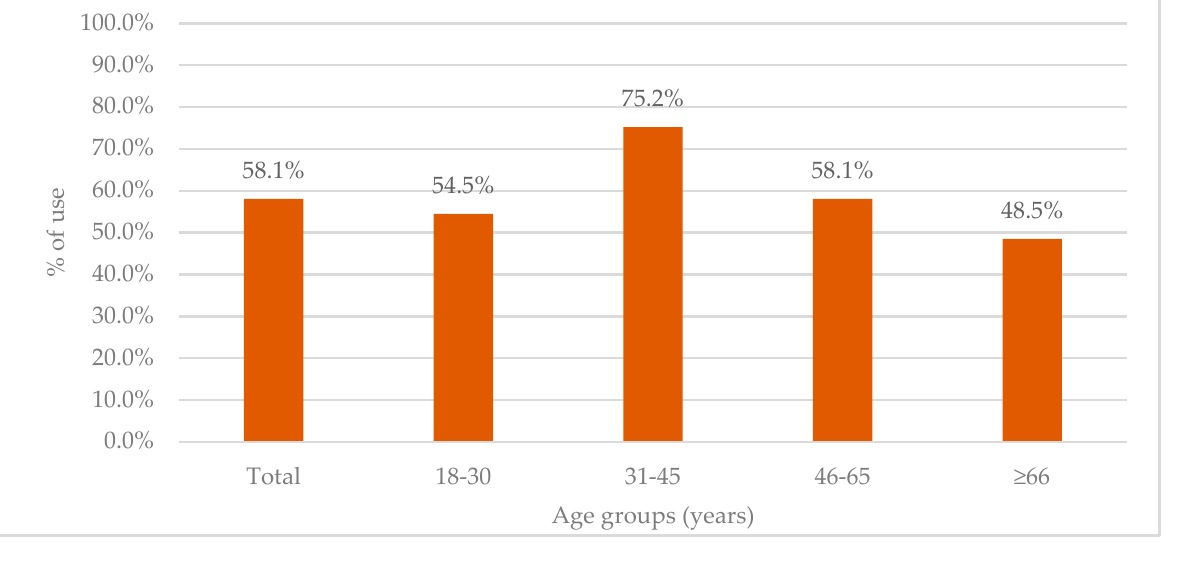
Figure 1. Pre-admission antibiotic use stratified across age groups . The most frequently used antibiotics used for COVID-19 treatment were macrolides (32.4%) cephalosporins (29.6%) and fluoroquinolones (28.2%). A third of patients (105, 34.5%) reported using more than one antibiotic. When analysing prior antimicrobial use across major age groups, three antibiotic groups emerged with a similar percentage of use (Figure 2). Cephalosporin use ranged from 27.4% in 46–65 years to 34.8% in 18–30 years, macrolide use ranged from 30.4% in 18–30 years to 33.3% in 31–45 years, whereas fluoroquinolones use ranged from 21.7% in 18–30 years to 30.6% in 66+ years.